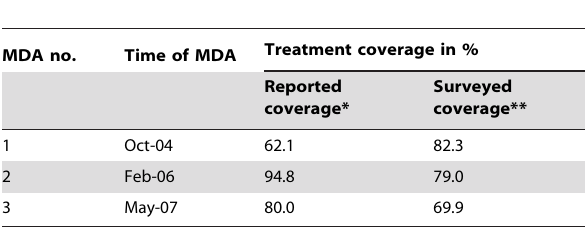
Table 3. Treatment coverage during mass drug administration (MDA) 1, 2 and